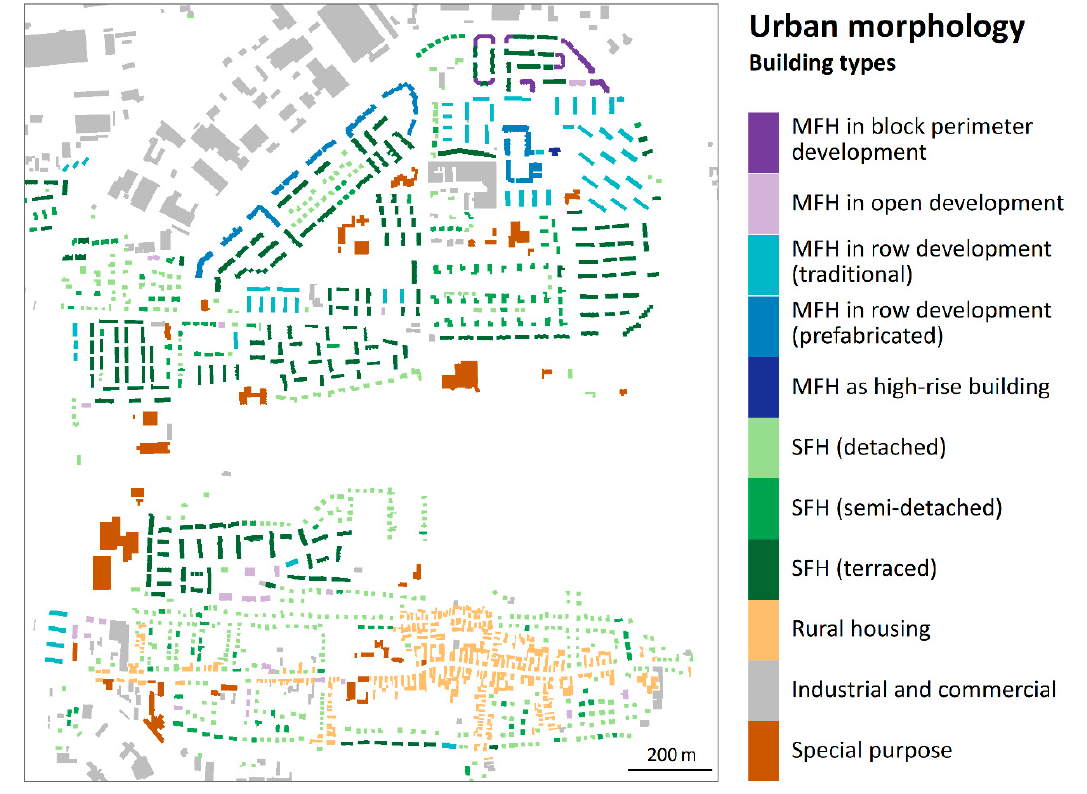
Figure 4. Result of the automatic building classification process for a subset of the study area.